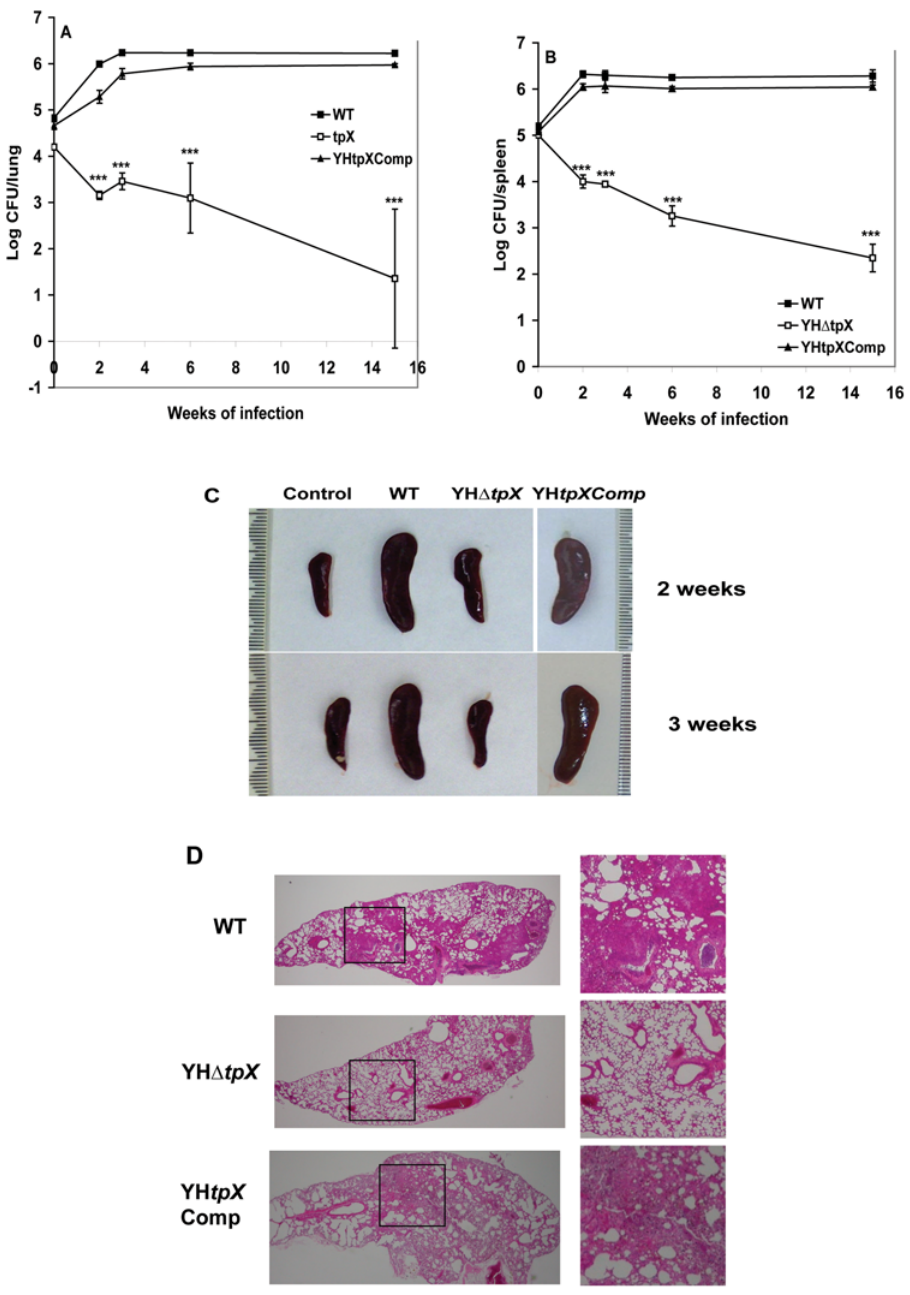
Figure 3. Growth and survival of YH D tpxin the lungs and spleen of BALBc mice. Mice were infected with 3 6 10 5 bacteria. At different time points the infected mice were sacrificed and the numbers of bacteria in the lung (A) or spleen (B) were measured. The results for each time point are the means and SDs of four mice in each experimental group. The experiments have been reproductively repeated twice with similar CFU counts in lungs and spleens. Statistical significance was determined by Student’s t test (***, P , 0.0001). C. Changes in spleen gross anatomy after infection with the WT, the mutant and the complemented strains. Spleens were collected at 2 and 3 weeks after infection. D. Lung histology of mice infected with the WT, the mutant and the complemented strains. Histopathological examination was performed using three mice in each group. Three sections from each mouse were examined. The images shown are representative of lung sections from three animals in each experimental group. Enlarged images of the boxed regions on the left panel (magnification, 4 6 ) are shown on the right panel (magnification, 10 6